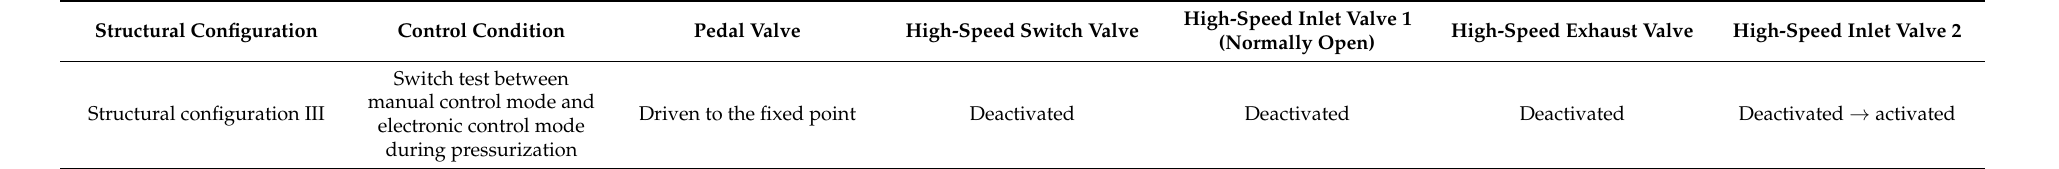
Table 4. Control conditions for the test of the pressure regulation characteristics of the APRV in structural configuration